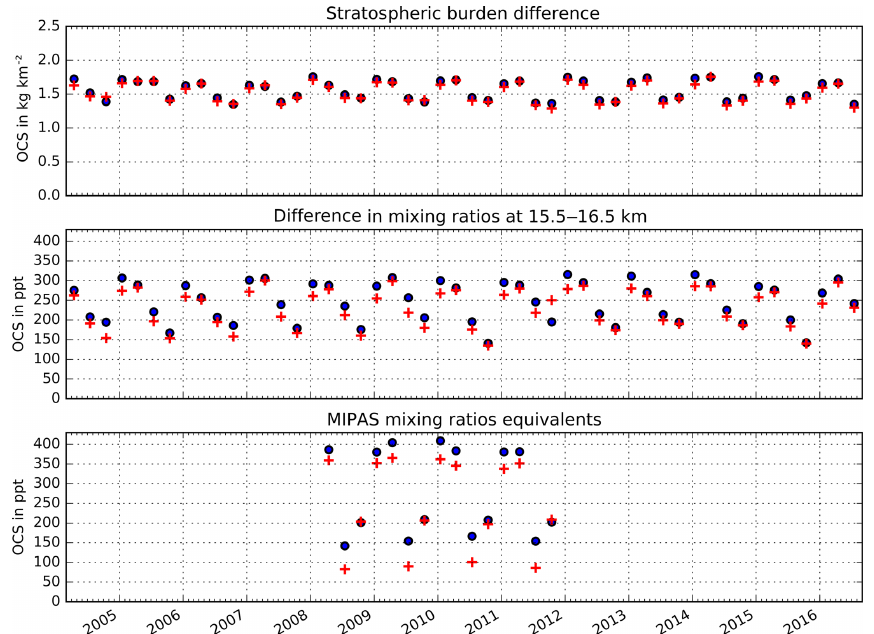
Figure 6. Comparison of the unadjusted (blue) and adjusted (red) seasonal ACE-FTS OCS stratospheric columns and seasonal averaged OCS mixing ratio from 15.5 to 16.5km altitude between 60 to 90 ◦ S and MIPAS OCS mixing ratio